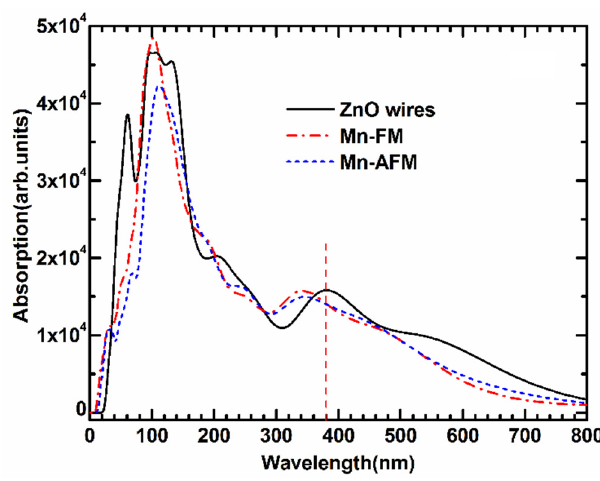
Figure 6. The optical absorption curves of FM and AFM for Mn-doped ZnO